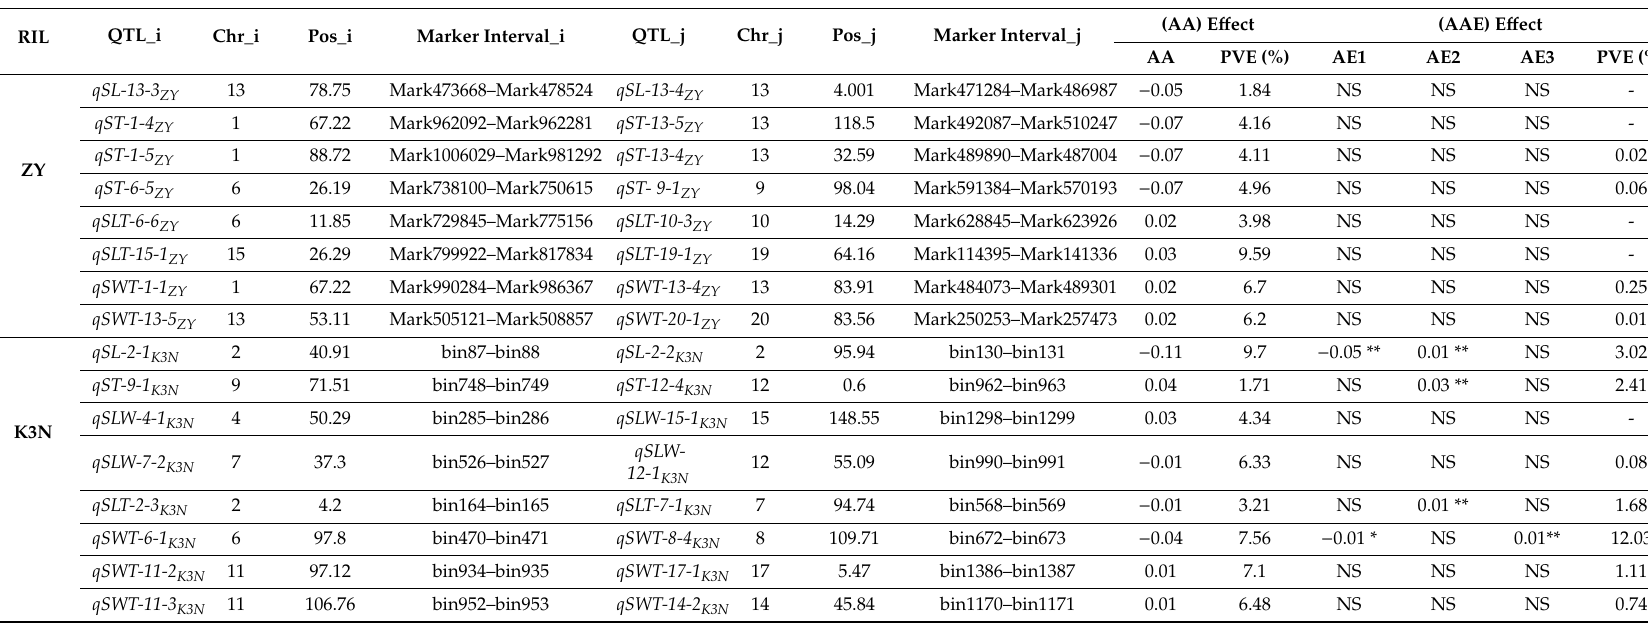
Table 4. Estimated epistatic e ff ects (AA) and environmental (AAE) interactions of QTLs for seed shape and size traits across all